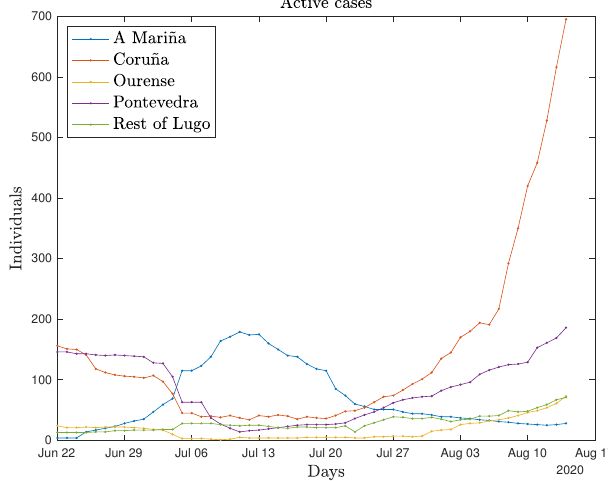
Figure 4. Active cases in the A Mariña area,